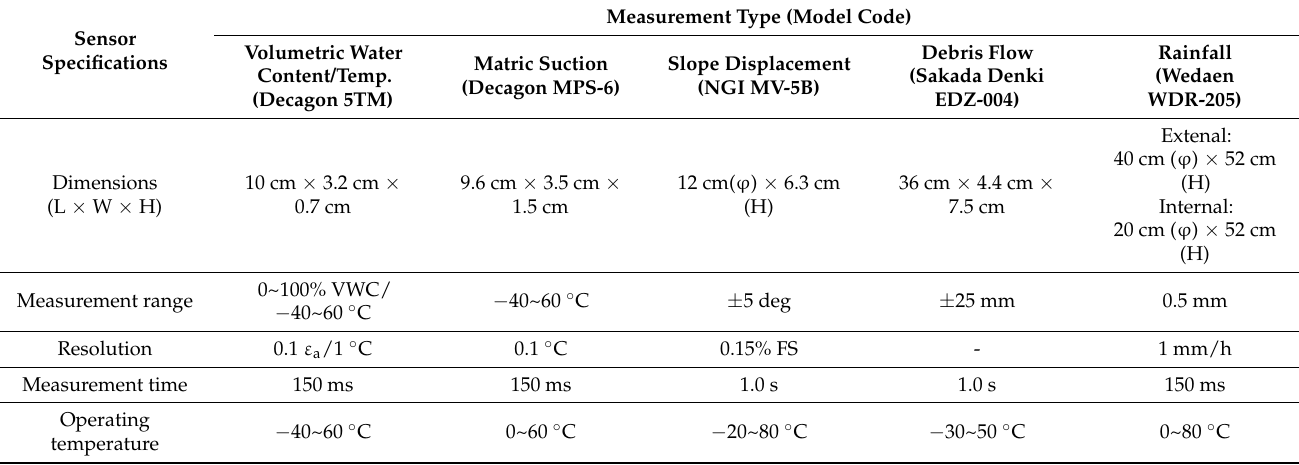
Table 1 lists the key specifications of the sensors installed in the landslide monitoring system. Table 1. Key specifications of the sensors in